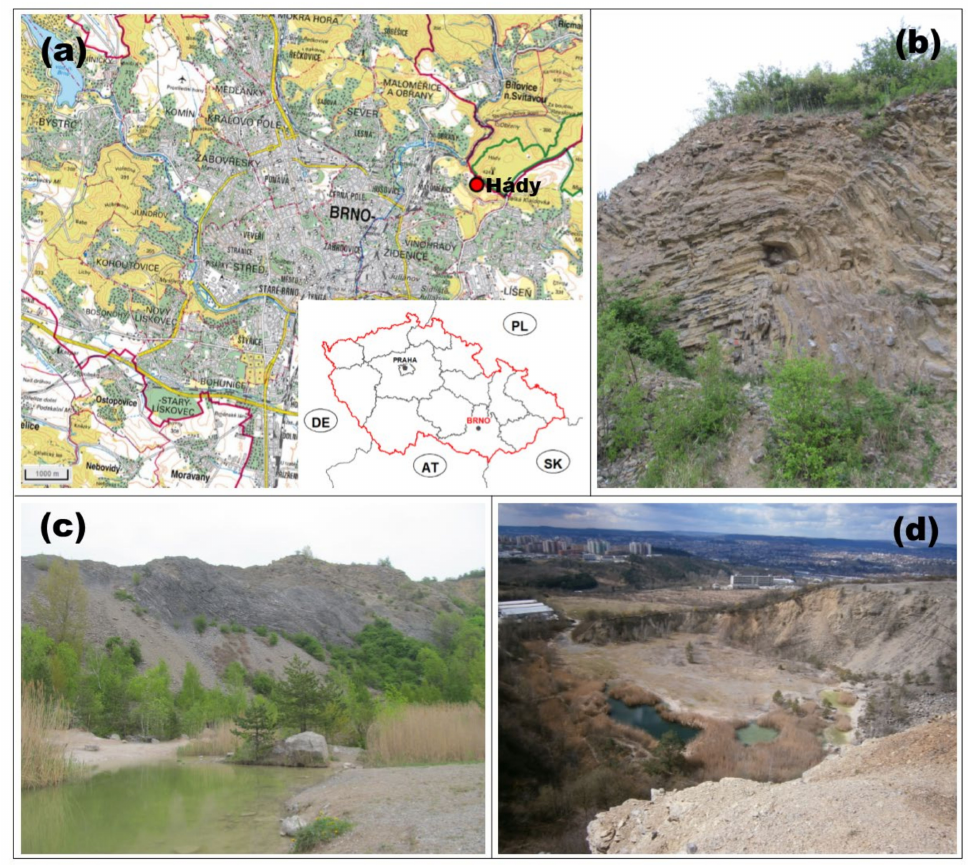
Figure 1. The area of collecting the data: abandoned limestone quarry of H á dy ( a )—position within the Brno city, ( b )—limestone folds on the upper bench, ( c )–lake on the bottom of the quarry, and ( d )–a view from the upper bench. Photo: